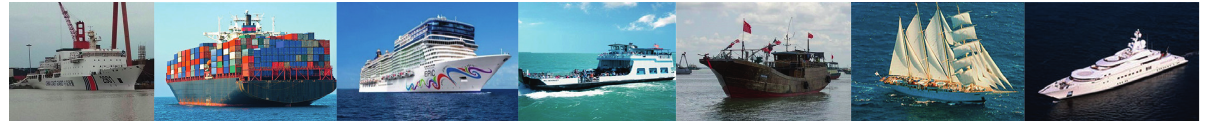
Figure 3: The dataset image demonstration: the coast guard ship, container ship, cruise ship, ferry, fishing boat, sailboat, and yacht.